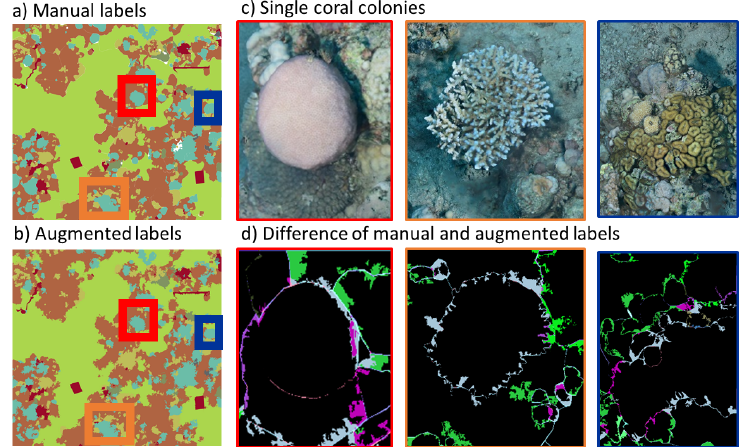
Figure 10. Comparison of the manual ( a ) and augmented labels ( b ) from sparsity 0.1%. ( c ) Close up views of the coral colonies in the areas indicated in coloured squares (left). ( d ) Substraction of the photomosaics shows that the differences occur along the edges of the segments. Black indicates no difference and colours indicates difference in pixel value.